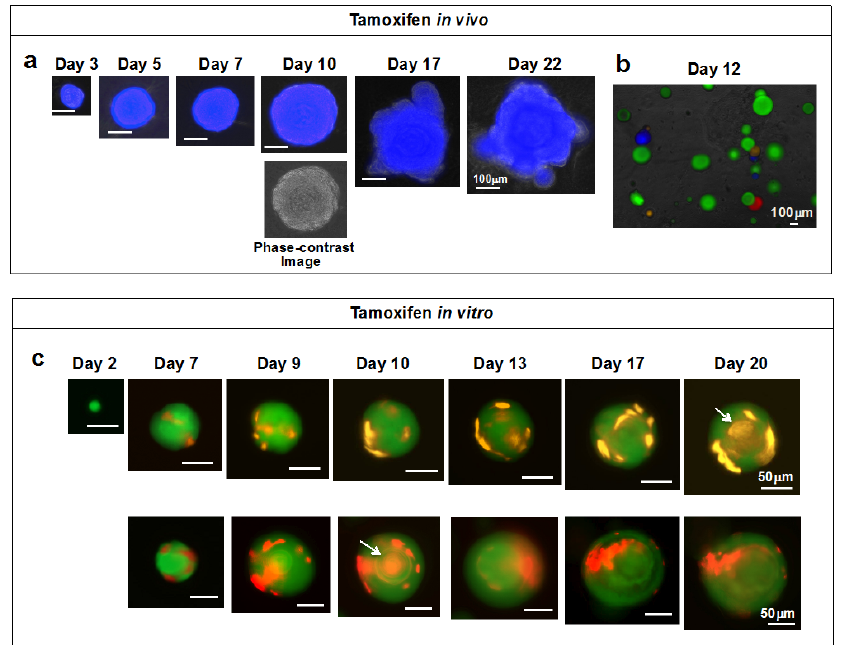
Figure 3. Potential of Bmi1-positive cells to generate organoids. ( a ) Time course of organoid growth ( in vivo administration of tamoxifen). Two days after administering tamoxifen, LECs from Bmi1-CreER ; Rosa26-rainbow mice were cultured in the organoid culture system for three days. Induction of Cre labeled individual cells red, orange, or blue, and the organoids showed mosaic patterns composed of the colored cells on day 5 of culture. Fluorescence image; ( b ) Representative photographs of organoids on day 12 of culture ( in vivo administration of tamoxifen). Most organoids were green, but some round-shape organoids were red, orange, or blue. Overlay of fluorescence image and phase-contrast image; ( c ) Time course of organoid growth ( in vitro administration of tamoxifen). Active form of tamoxifen was added to the LECs from Bmi1-CreER ; Rosa26-rainbow mice at the start of culture. Bmi1-positive cells were induced by the tamoxifen to turn red or orange and formed colored stratum corneum (indicated by arrows). Modified from [34].